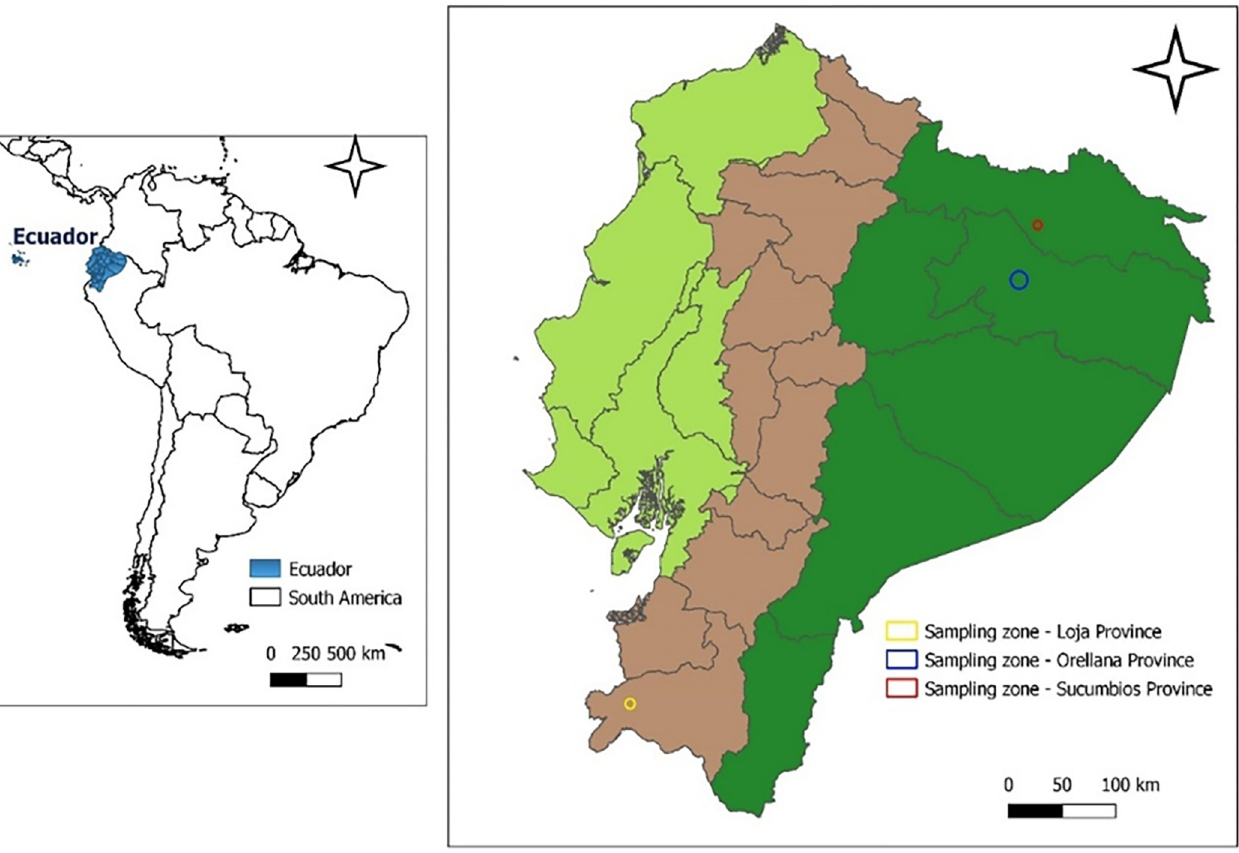
Fig 1. Geographical location of the study areas, in three provinces of Ecuador. Layers were obtained from: http://www.efrainmaps.es. Carlos Efraı´n Porto Tapique´n. Geography, GIS and Digital Cartography. Valencia, Spain, 2020 for America layer, Instituto Geogra´fico Militar, 2008, Base nacional escala 1:1’00.000 for Ecuador layer.